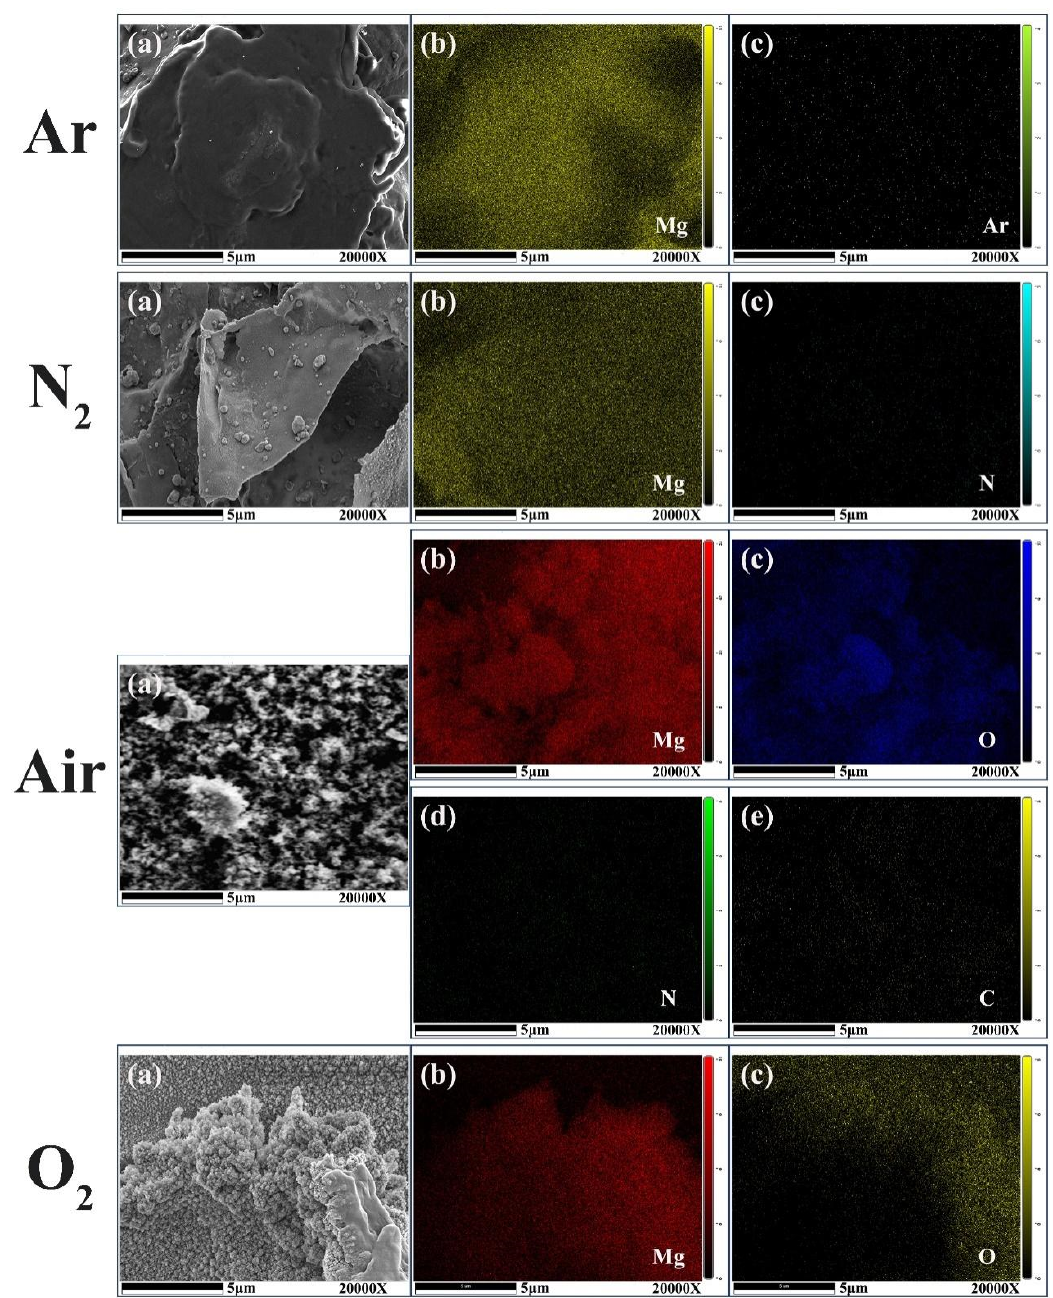
Figure 12. Pictures of EDS mapping of combustion residue constituents of Mg microparticles in inert and oxidizing at- mospheres.